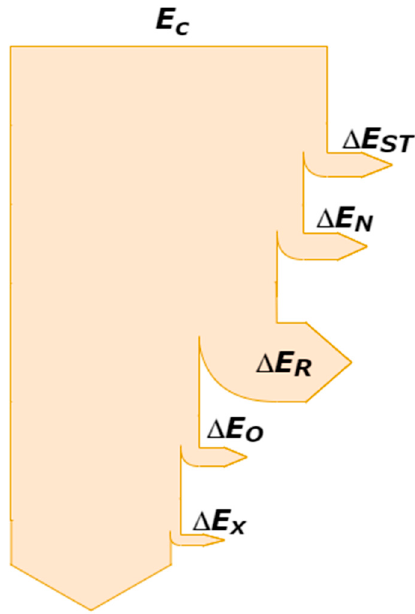
Figure 20. The energy flow during the shredding process.